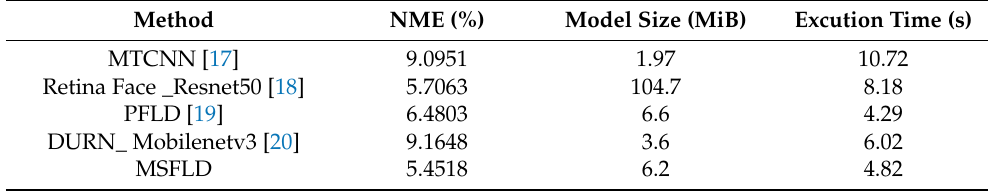
Figure 6. Detection results of 23 key points using various methods on the HNUFDD dataset. Table 3. Comparison of different methods on the HNUFDD dataset for facial key point detection.